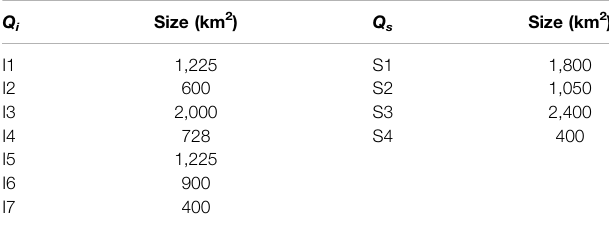
TABLE 3 | Average sizes ofidenti fi ed anomalies in the Aeolian Islands region (total area (cid:1) 16,800 km 2